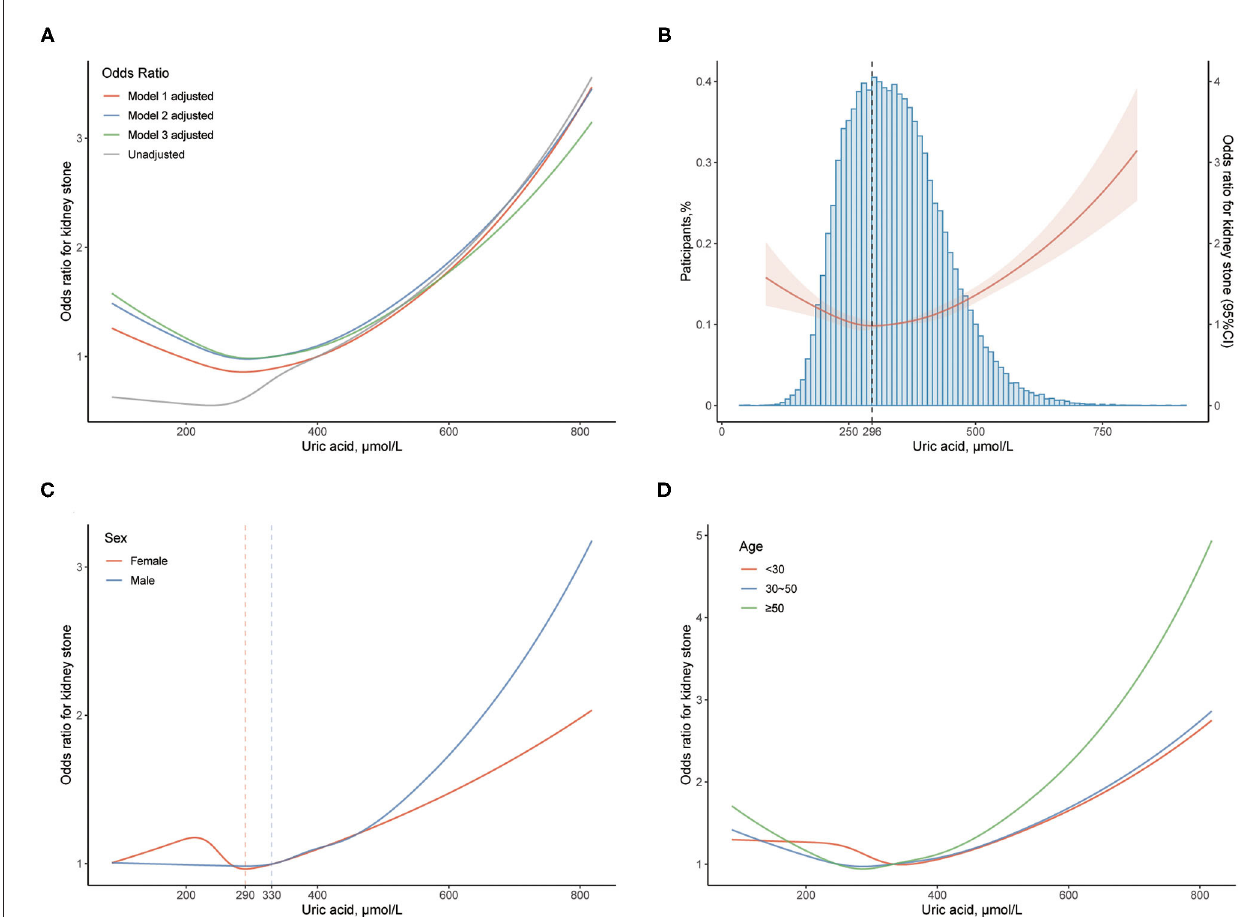
FIGURE 1 | Association between uric acid (UA) level and kidney stone (KS). (A) The odds ratio (OR) is indicated by the curves with multivariable adjustment. (B) The OR with 95% CI is indicated by the red line and shade; blue histogram implies the proportion of the participants. The dashed line reveals the UA level (296 µ mol/L) where the odds of KS start to increase. (C) The OR is stratified by sex. The dashed lines indicate the UA levels (330 and 290 µ mol/L) where the odds of KS start to increase in male and female, respectively. (D) The OR is stratified by age. The OR with 95% CI of KS is calculated by taking UA level of 400 µ mol/L as reference. Models: see Methods-Statistical analyses Section for descriptions of models 1, 2, and 3. Model 3 is applied unless